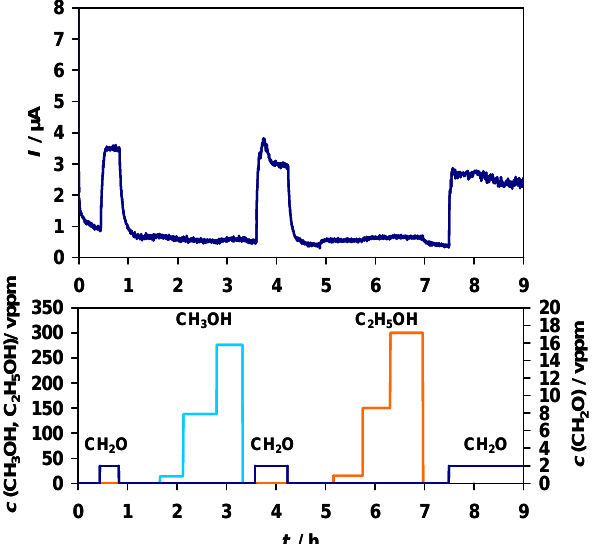
Figure 6. Top: Amperometric sensor signal for 2 vppm formaldehyde and interferences from methanol (0 - 276 vppm) and ethanol (0 - 300 vppm). Bottom: Test cycle concentrations of methanol and ethanol (left y-axis) and formaldehyde (right